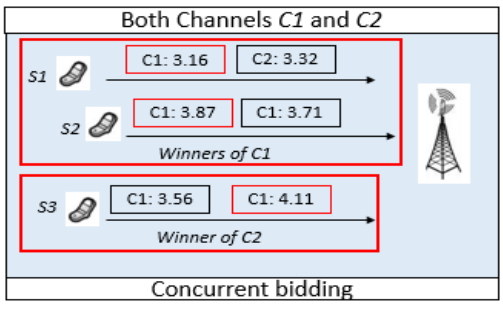
Figure 4. Concurrent bidding for heterogeneous channels.